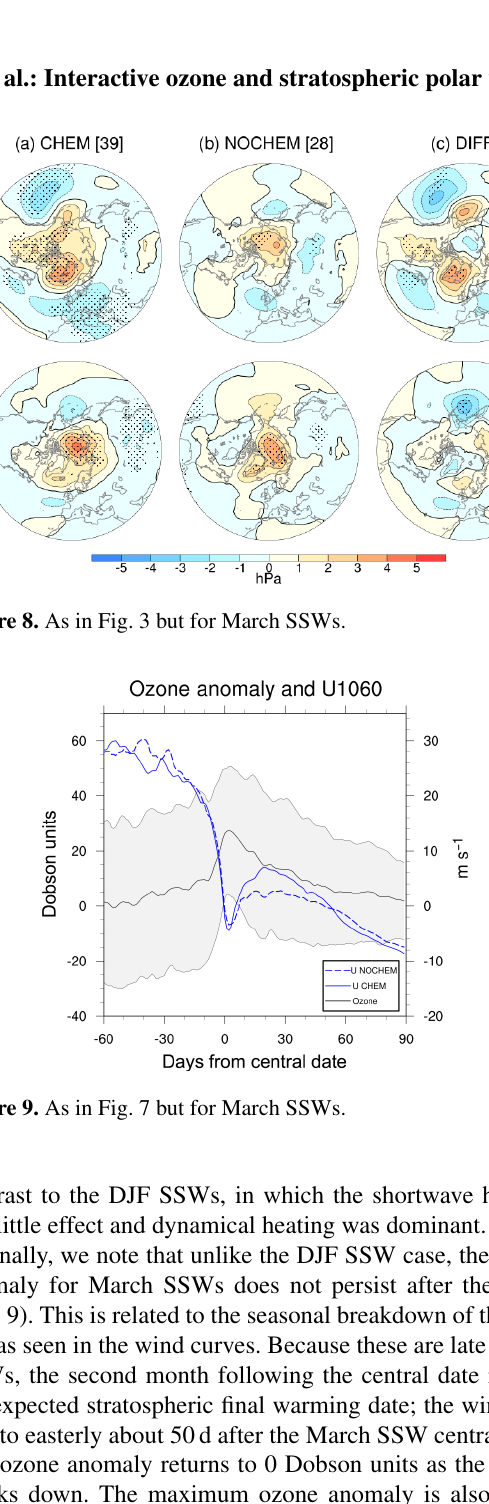
strong and persistent than the difference seen after midwinter SSWs.